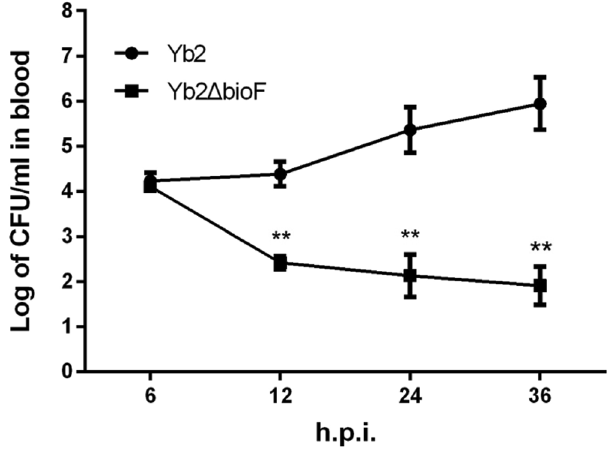
Figure 8. Bacterial loads in blood of Riemerella anatipestifer infected ducks. Six ducks each were infected with the bacterial culture at a dose of 1 × 10 8 CFU. The bacterial loads in blood samples were counted at 6 hpi, 12 hpi, 24 hpi, and 36 hpi. Data represent mean ± standard deviation, and were analyzed using two-tailed independent Student’s t test ( ** p <